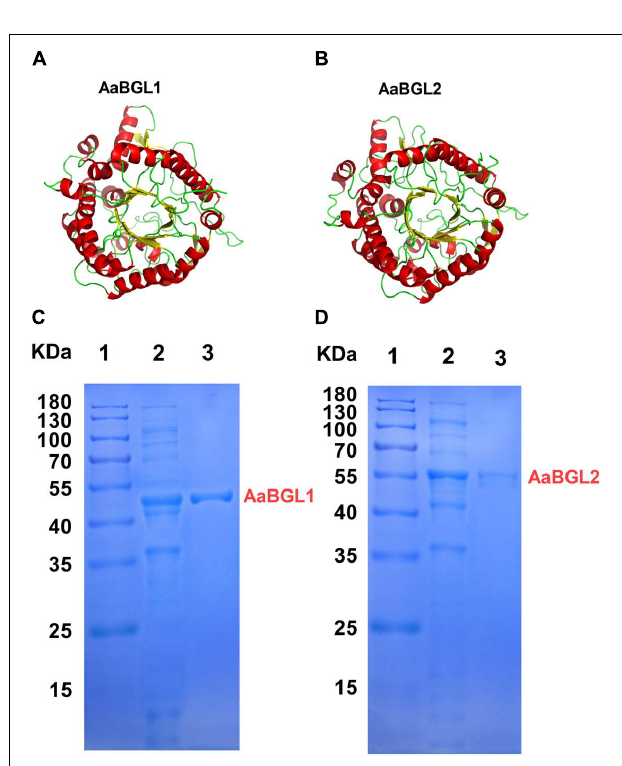
FIGURE 4 | Three-dimensional model and purification of β -glucosidases AaBGL1 and AaBGL2. Structural models of (A) AaBGL1 and (B) AaBGL2. Sodium dodecyl sulfate polyacrylamide gel electrophoresis analysis of recombinant (C) AaBGL1 and (D) AaBGL2 produced by E. coli BL21. Lane 1, protein molecular weight marker, mass indicated on the left; lane 2, total protein in IPTG-induced E. coli BL21/ pET 28a-aabgl1 or pET 28a-aabgl2; lane 3, purified AaBGL1 or